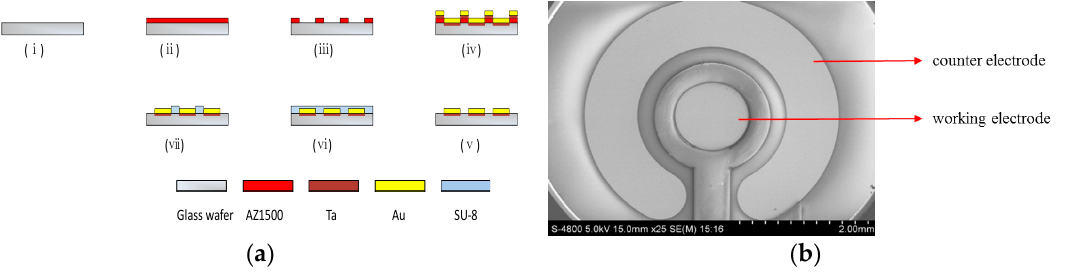
Figure 1. The ( a ) fabrication process: (i) glass wafer cleaning; (ii) AZ1500 patterning; (iii) photolithography; (iv) Ta/Au layer sputtering; (v) lift off process; (vi) SU-8 patterning; (vii) photolithography; and ( b ) scanning electron microscope (SEM) image of the microelectrode chip.